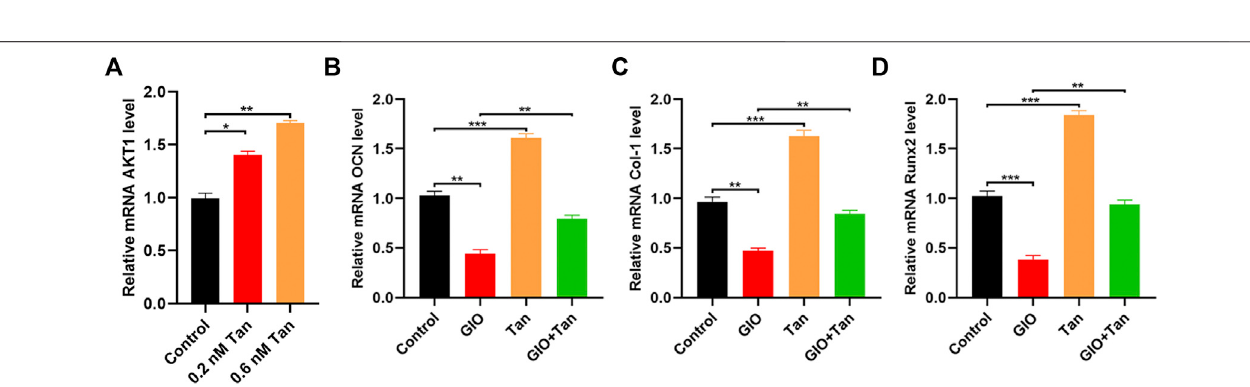
FIGURE6| Tanshinone alleviates osteoporosisby targeting AKT1. MSCsweretreatedwith PBS,0.2 nM Tanshinone, and 0.6 nM Tanshinone (A) The expression of AKT1 was assessed by qRT-PCR; (B – D) qRT-PCR analysis for the osteogenesis-related mRNAs (OCN, Col-1, Runx2) among the four groups. * p < 0.05, ** p < 0.01, *** p < 0.001.